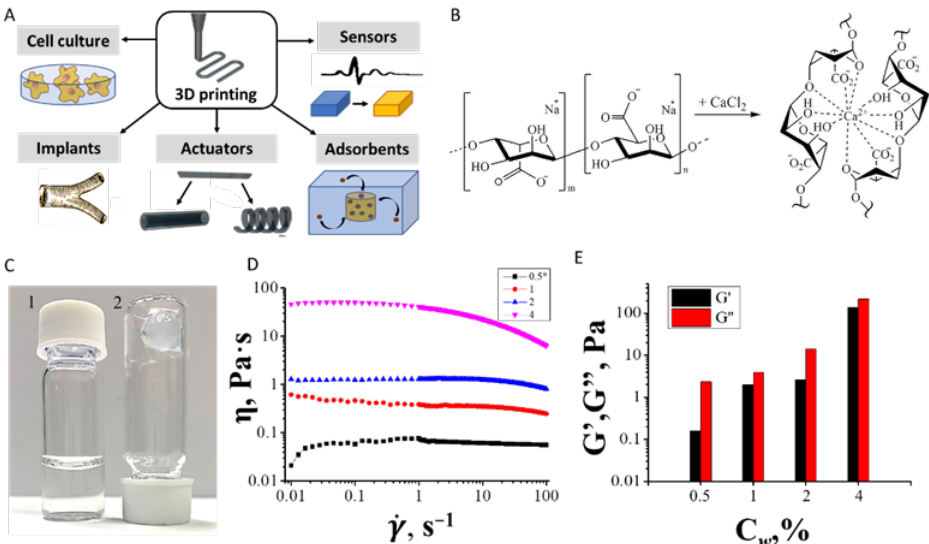
Figure 5. Scheme and application of continuous printing and its ink parameters of continuous printing. ( A ) gel printing sample and examples of the application of printed structures, ( B ) scheme of gel formation during treatment of sodium alginate with a concentrated solution of calcium chloride, ( C ) example of a alginate-based inks before (left) and immediately after (right) treatment with calcium chloride, ( D ) variation of ink viscosity from 0.5, 1, 2 and 4 wt% alginate depending on the shear rate, ( E ) storage (G′) and loss (G′′) moduli of sample containing alginate 0.5, 1, 2 and 4 wt%.